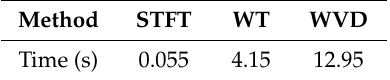
Table 3. Computational costs of analysis methods for 10